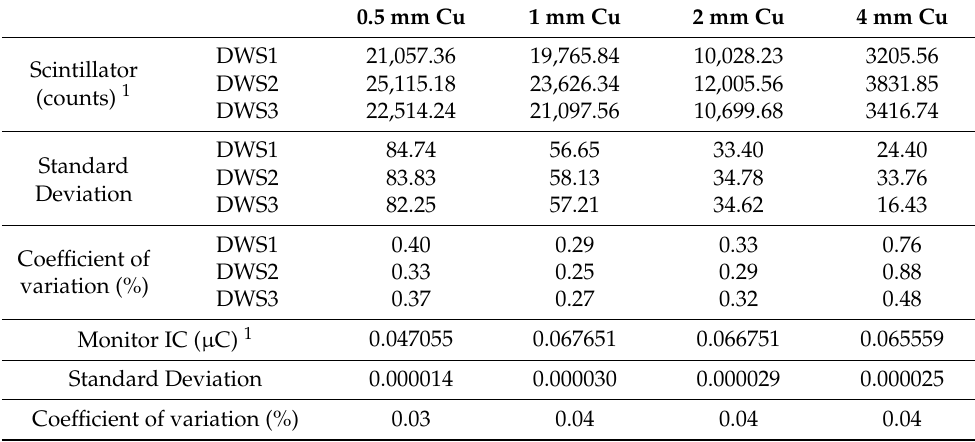
Table 2. Repeatability measurements for the scintillator detectors.